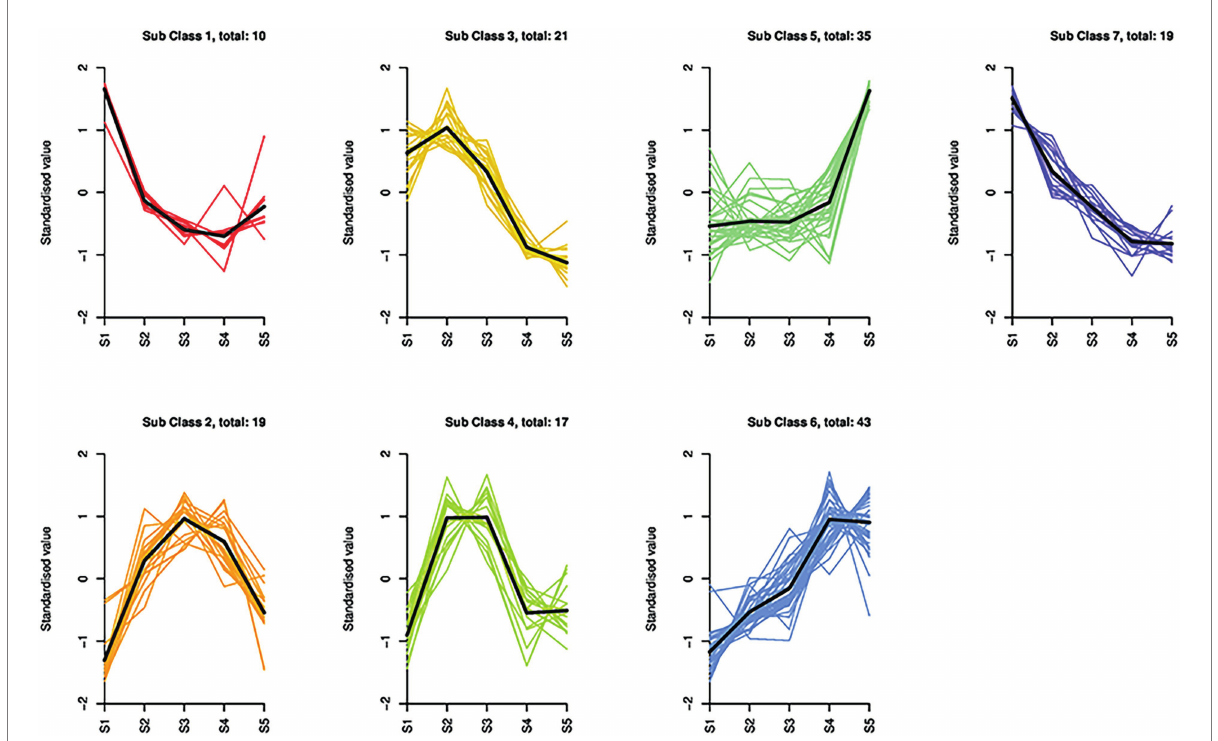
FIGURE 3 Dynamics of the differential metabolites in S. japonica flowers during maturation. Based on K-means cluster analysis, 164 differential metabolites were divided into seven subclasses containing 10, 19, 21, 17, 35, 43, and 19